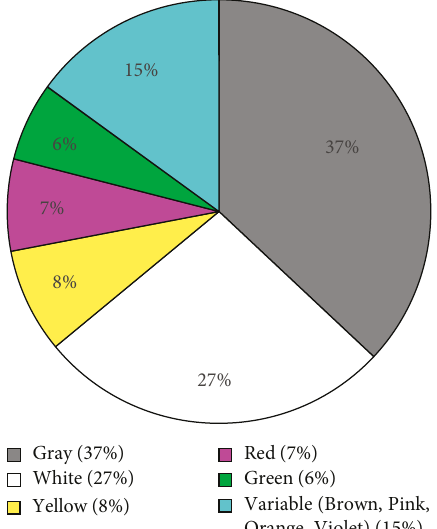
Figure 2: Percentage distribution of Streptomyces isolates according to colony color as observed on starch casein agar.